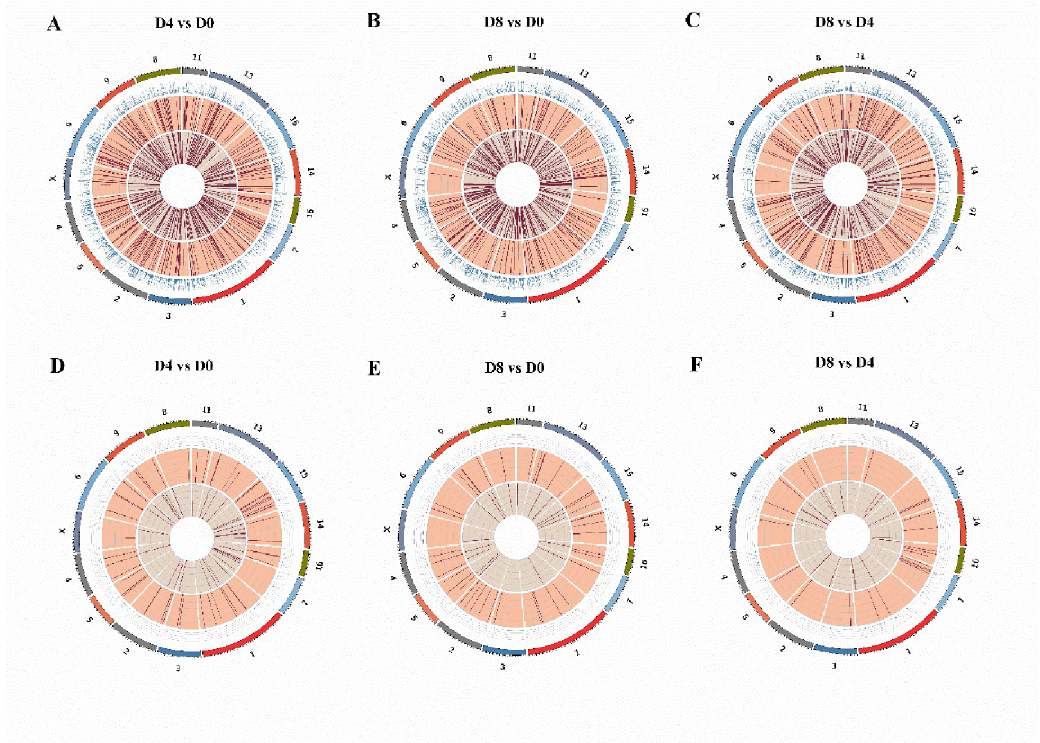
Fig 3. Circos map analysis of differentially distributed mRNA (A-C) and lncRNA (D-F).